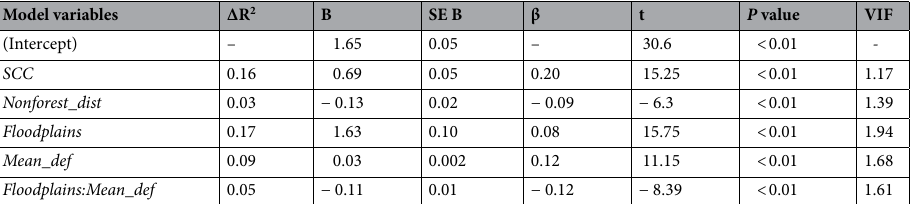
Table 1. Estimated regression parameters (B), standard errors (SE B), t values (t) and p values for the generalized linear model (GLM) to estimate gap fraction. Standardized beta coefficients (β), ΔR 2 (change in R 2 by adding the variable last to the model) and variance-inflation factors (VIF) for each predictor were also reported. Model achieved R 2 of 0.57. SCC soil cation concentration, Nonforest_dist distance to the nearest non-